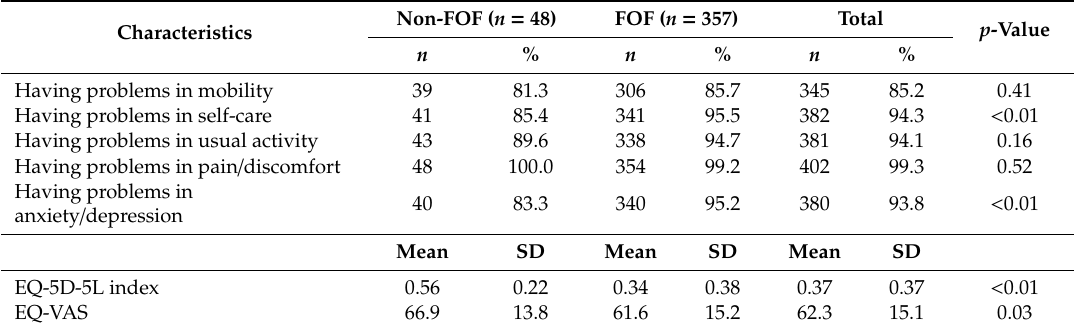
Table 4. Percentage of patients having problems in each domain of EQ-5D-5L according to FOF